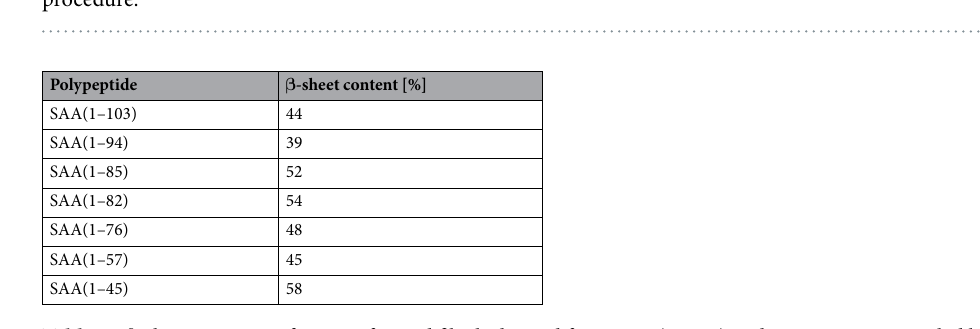
Table 2. β -sheet contents of in vitro formed fibrils derived from SAA(1–103) and AA proteins, revealed by